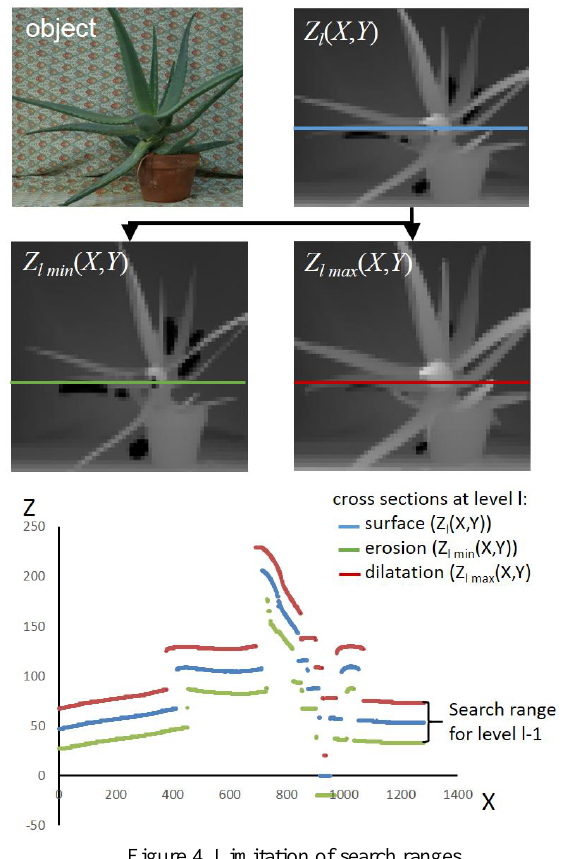
direction with a constant offset of -2·Δ Z l and +2·Δ Z l